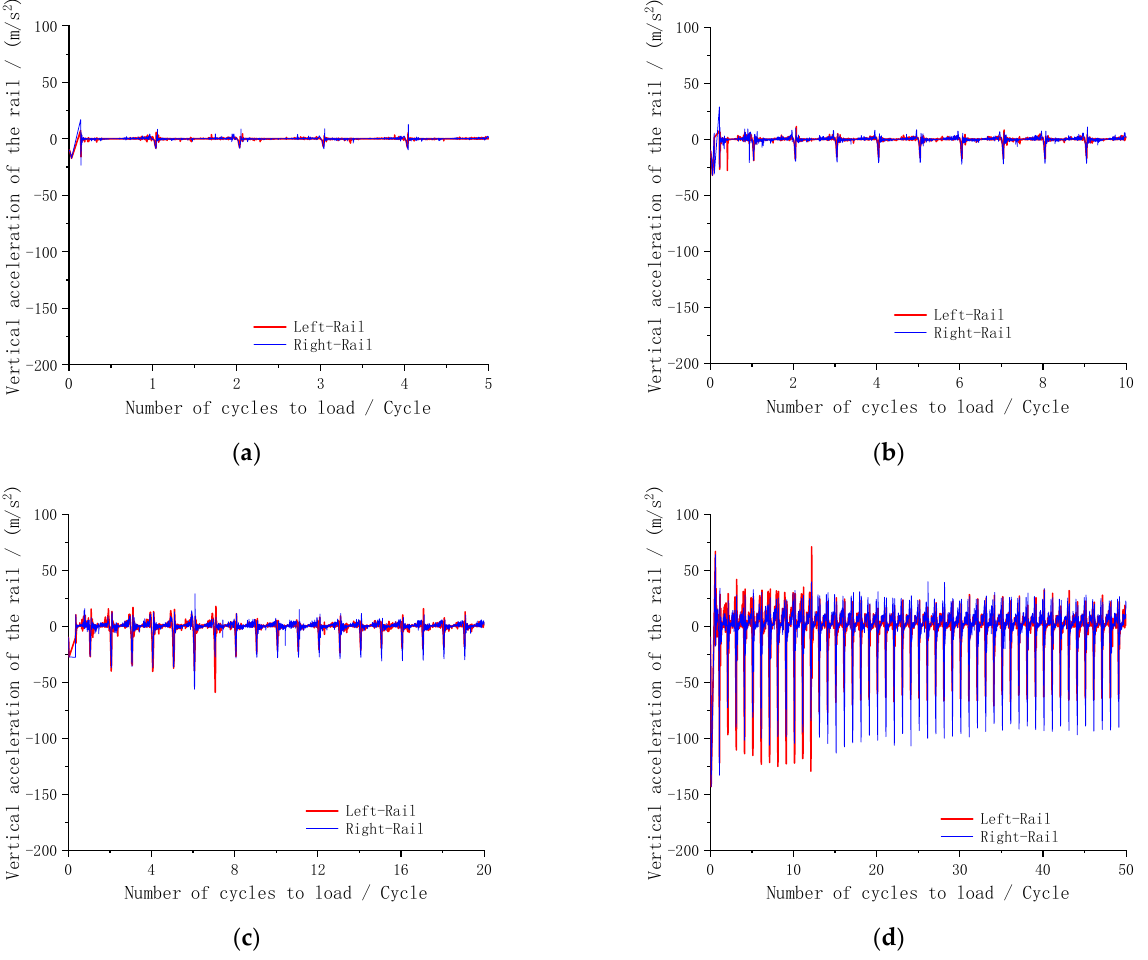
Figure 14. The vertical acceleration curve of the rail. ( a ) 5 Hz. ( b ) 10 Hz. ( c ) 20 Hz. ( d ) 50 Hz. Observing the variation of the rail acceleration, it can be seen that when the loading frequencies were 5 Hz, 10 Hz, 20 Hz, and 50 Hz, the corresponding maximum rail accelera- tions were 20 m/s 2 , 30 m/s 2 , 60 m/s 2 , and 150 m/s 2 , respectively. The vertical